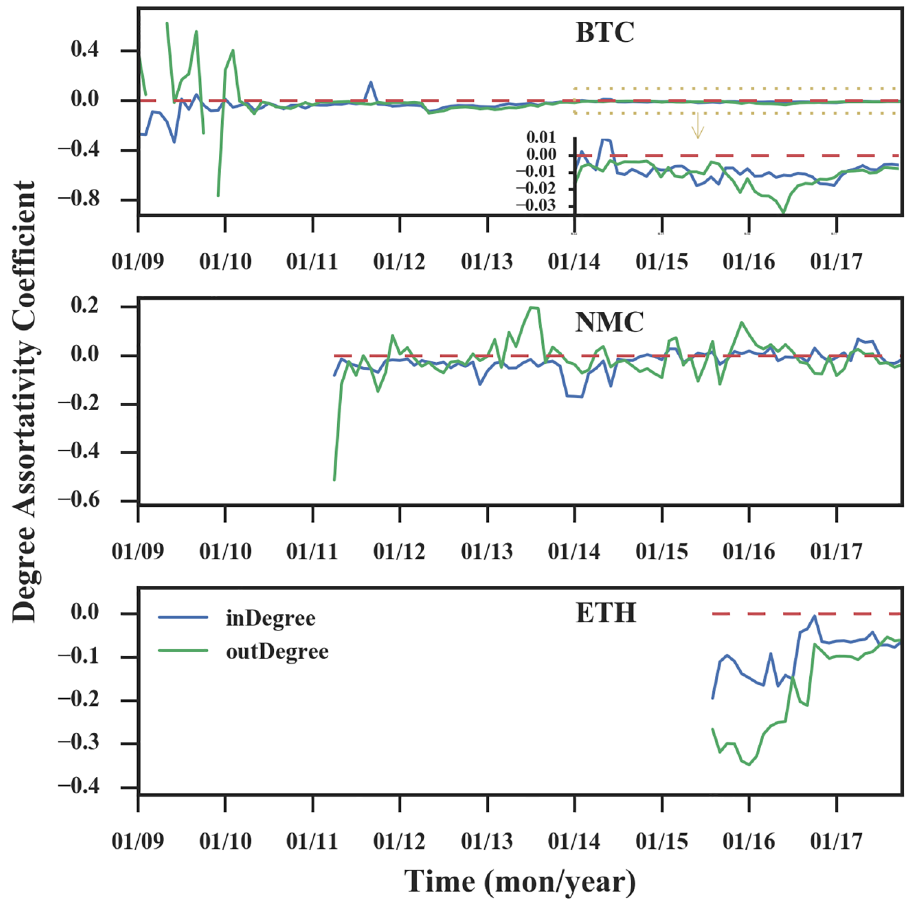
Fig 7. Evolution of the degree assortativity. In the figure of Bitcoin, we magnify the y-axis of the data in the yellow box and display it in the bottom right corner. After the initial phase, the coefficients of Bitcoin and Ethereum are negative, and the coefficient of Namecoin converges to a certain range near